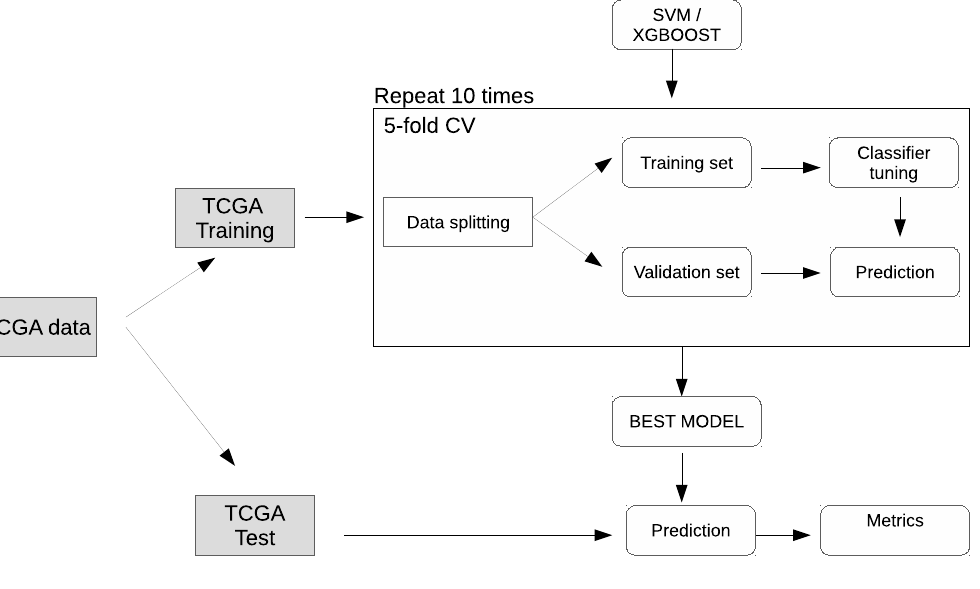
Figure A5. Graphical representation of the pipeline used to develop the model for classifying the TMB/TGF- β score positive